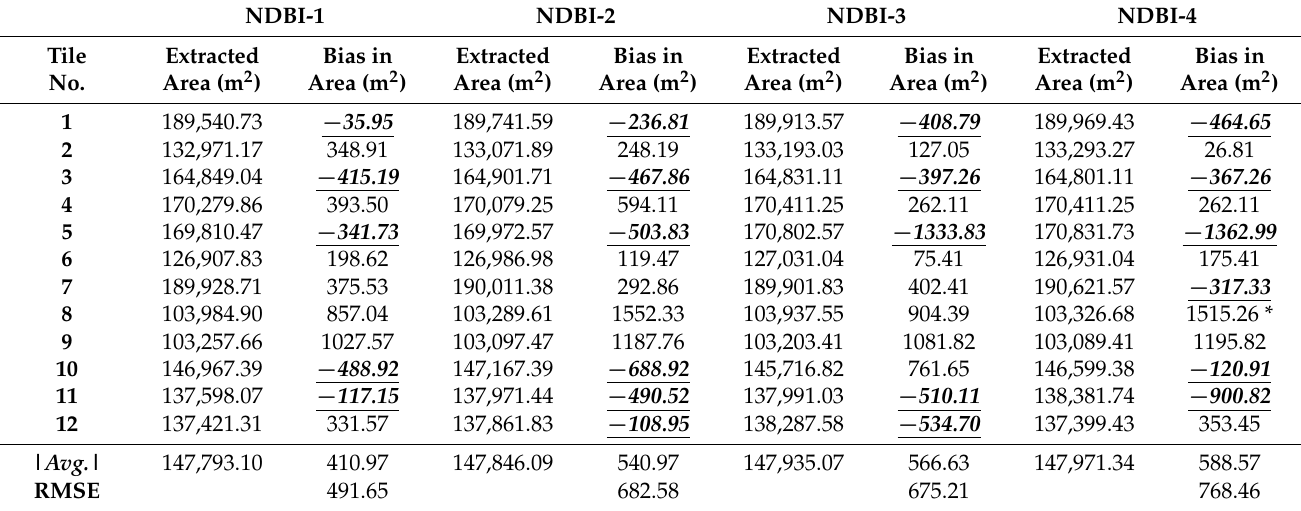
Table 4. Sample data summarizing the reference blue ice area (manually digitized and cross-verified with ground survey) for the 12 tiles containing blue ice and their respective blue ice areas extracted by the customized NDBI approach using GS-sharpened images. Negative bias values representing overall overestimation of blue ice are highlighted with bold italics and underlined text. Outliers are highlighted with